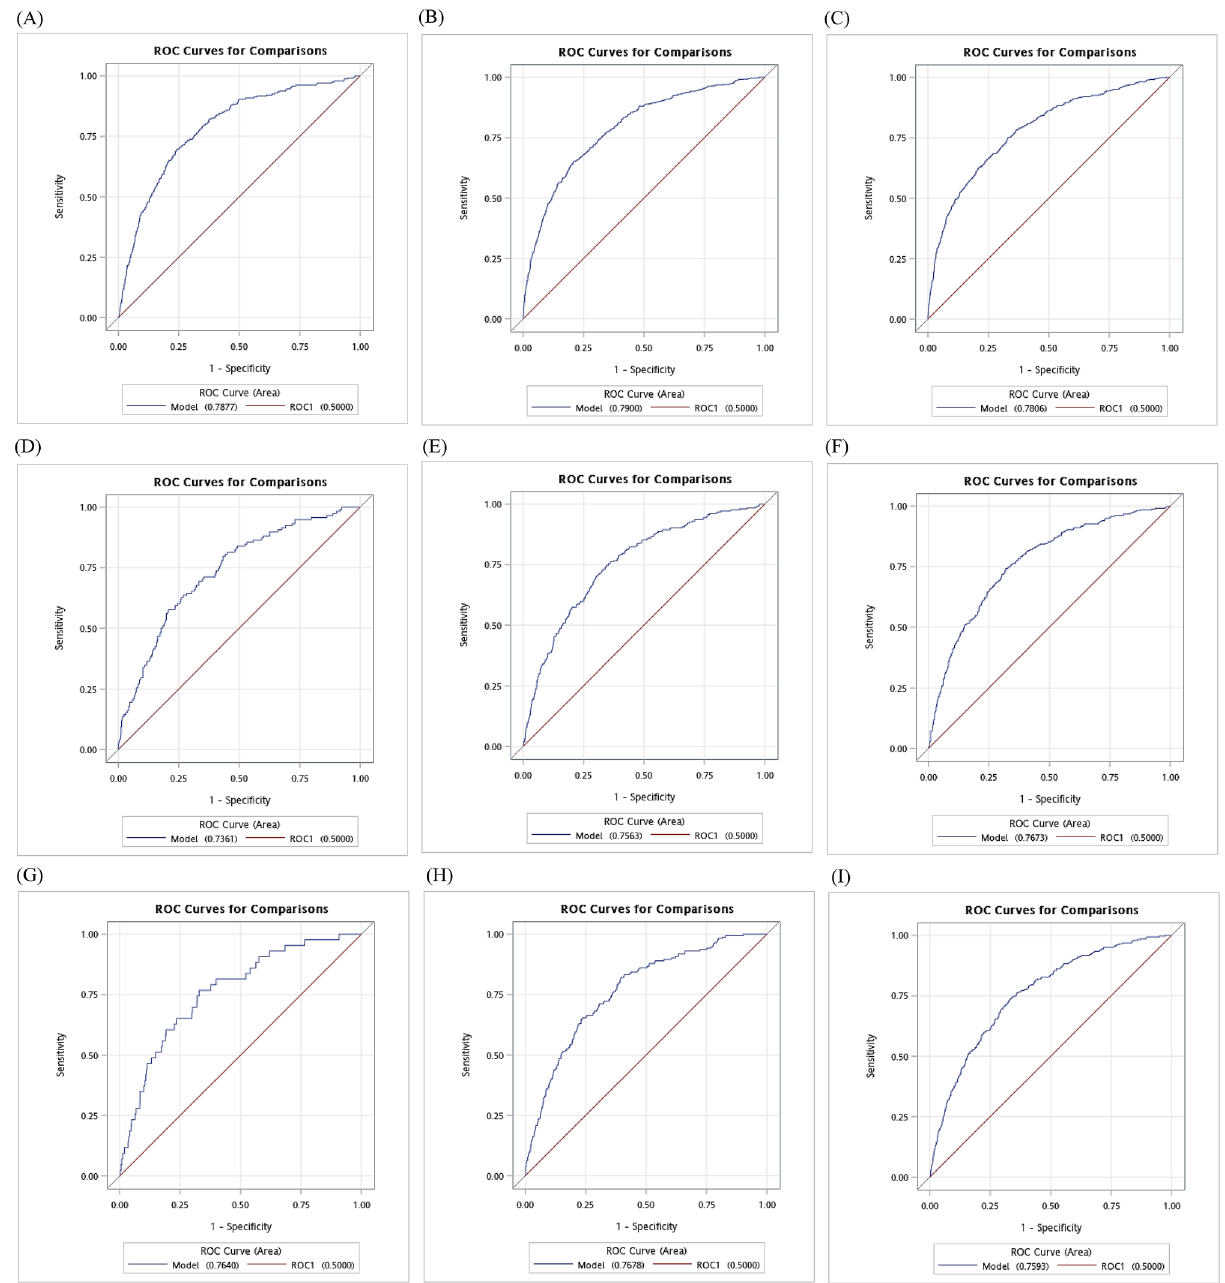
Figure 1. Receiver operating characteristic curves (ROCs) for 1-year ( A ), 3-year ( B ), and 5-year ( C ) CKD risk in derivation set, 1-year ( D ), 3-year ( E ), and 5-year ( F ) CKD risk in validation set, and 1-year (G), 3-year ( H ), and 5-year ( I ) CKD risk in the sample for external